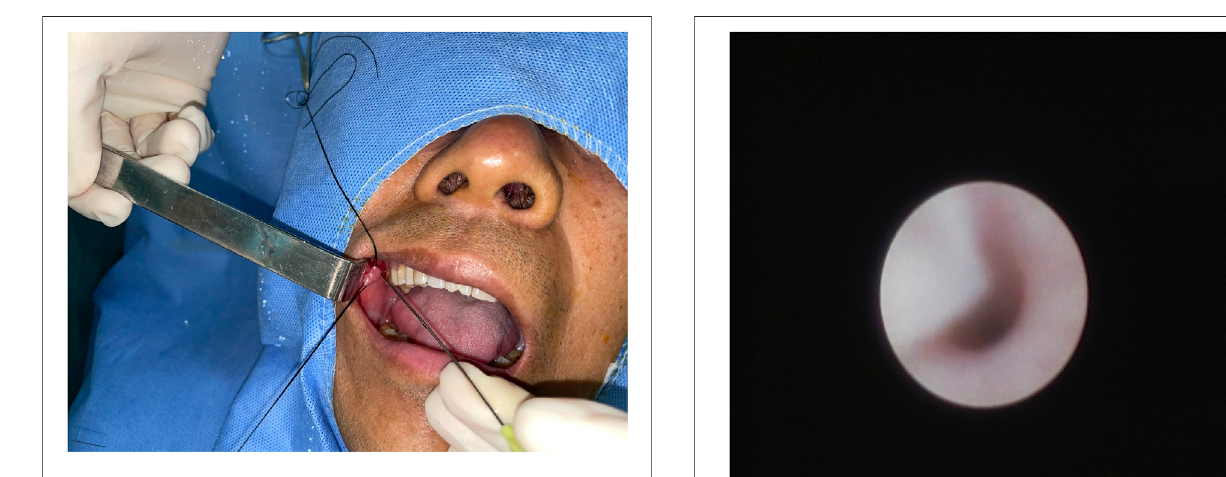
FIGURE 1 | Surgical procedure: The sialendoscope was introduced through the ori fi ce.